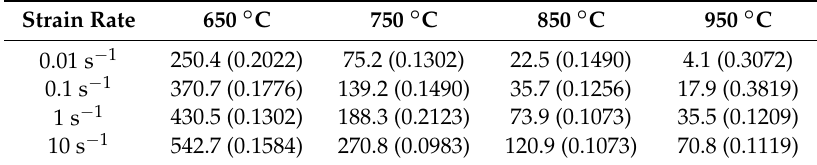
Table 3. Critical stress (MPa) and corresponding strain of the Fe-6.5wt. %Si